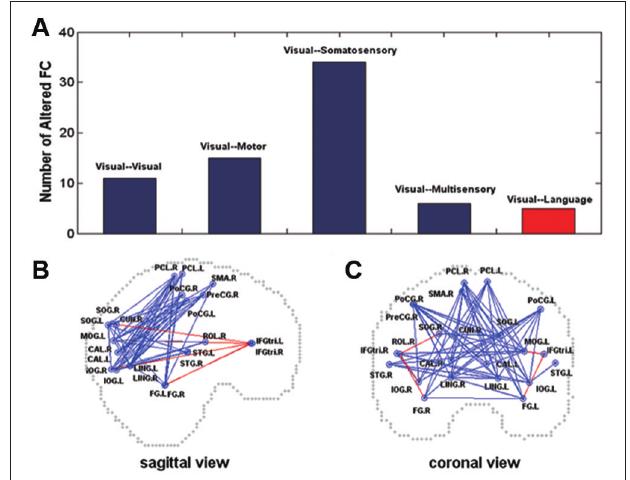
FIGURE 4 | Altered functional connectivity in the early blind (A) shown on sagittal (B) and coronal (C) views . In (A) , the y -axis indicates the number of the pairs with altered functional connectivity. In (B) and (C) , the dots represent the centroids of each brain region. The blue color represents decreased functional connectivity and the red color denotes increased functional connectivity in the early blind. FC = functional connectivity (Liu et al.,